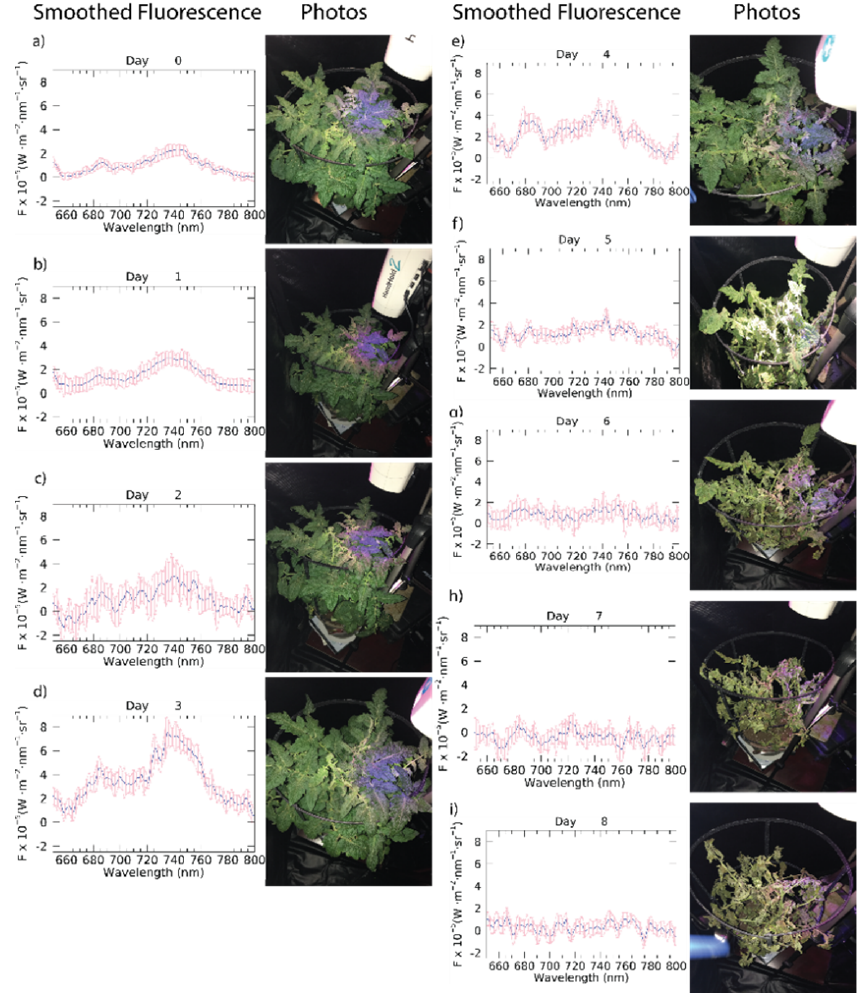
Figure A1. Daily average smoothed fluorescence and photographs of target tomato plant for all days of experiment (Days 0 to 8 spectra and photographs labelled ( a – i ), respectively).